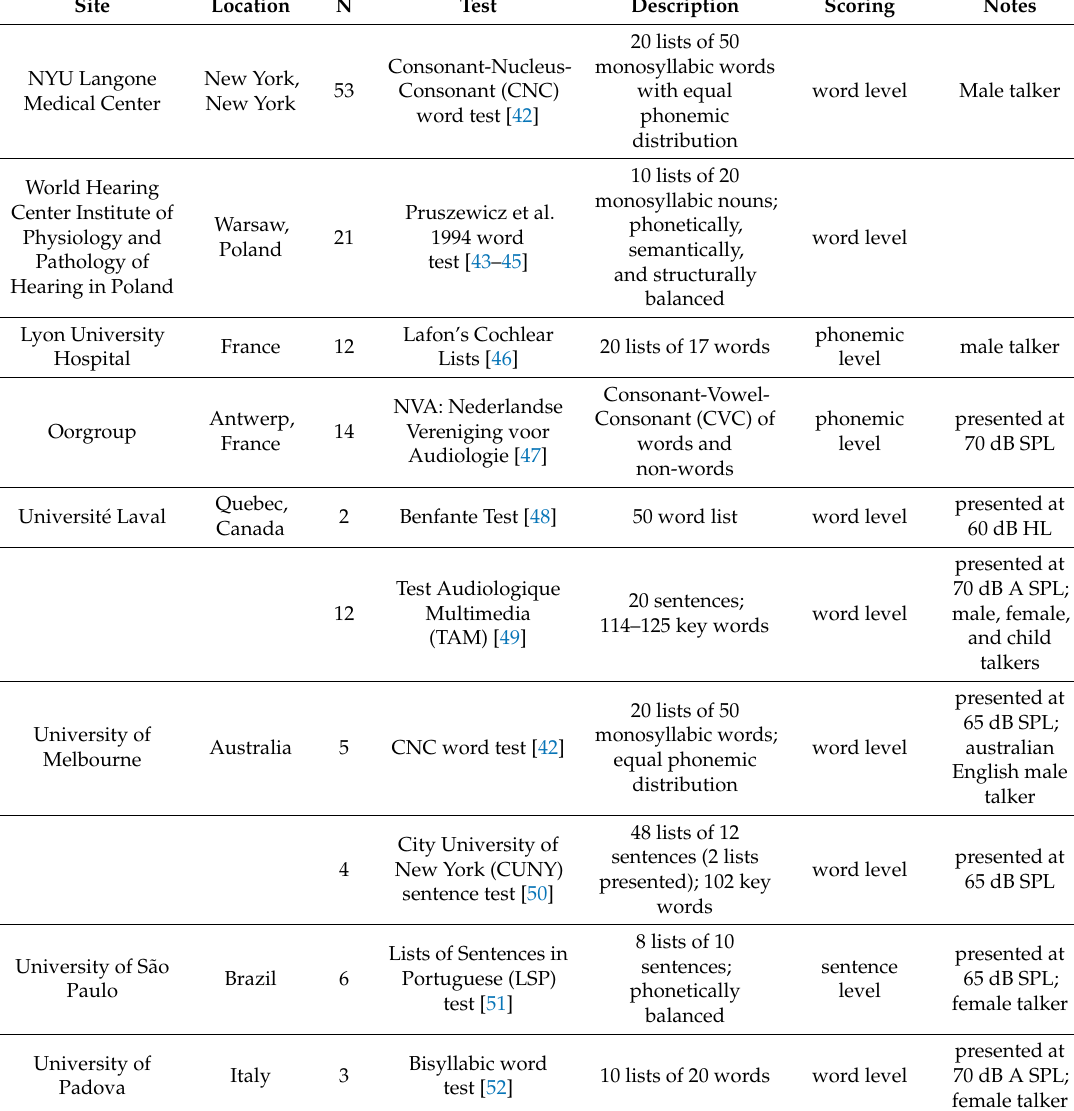
Table A1. Summary of testing materials. * presented at 65 dB HL unless noted